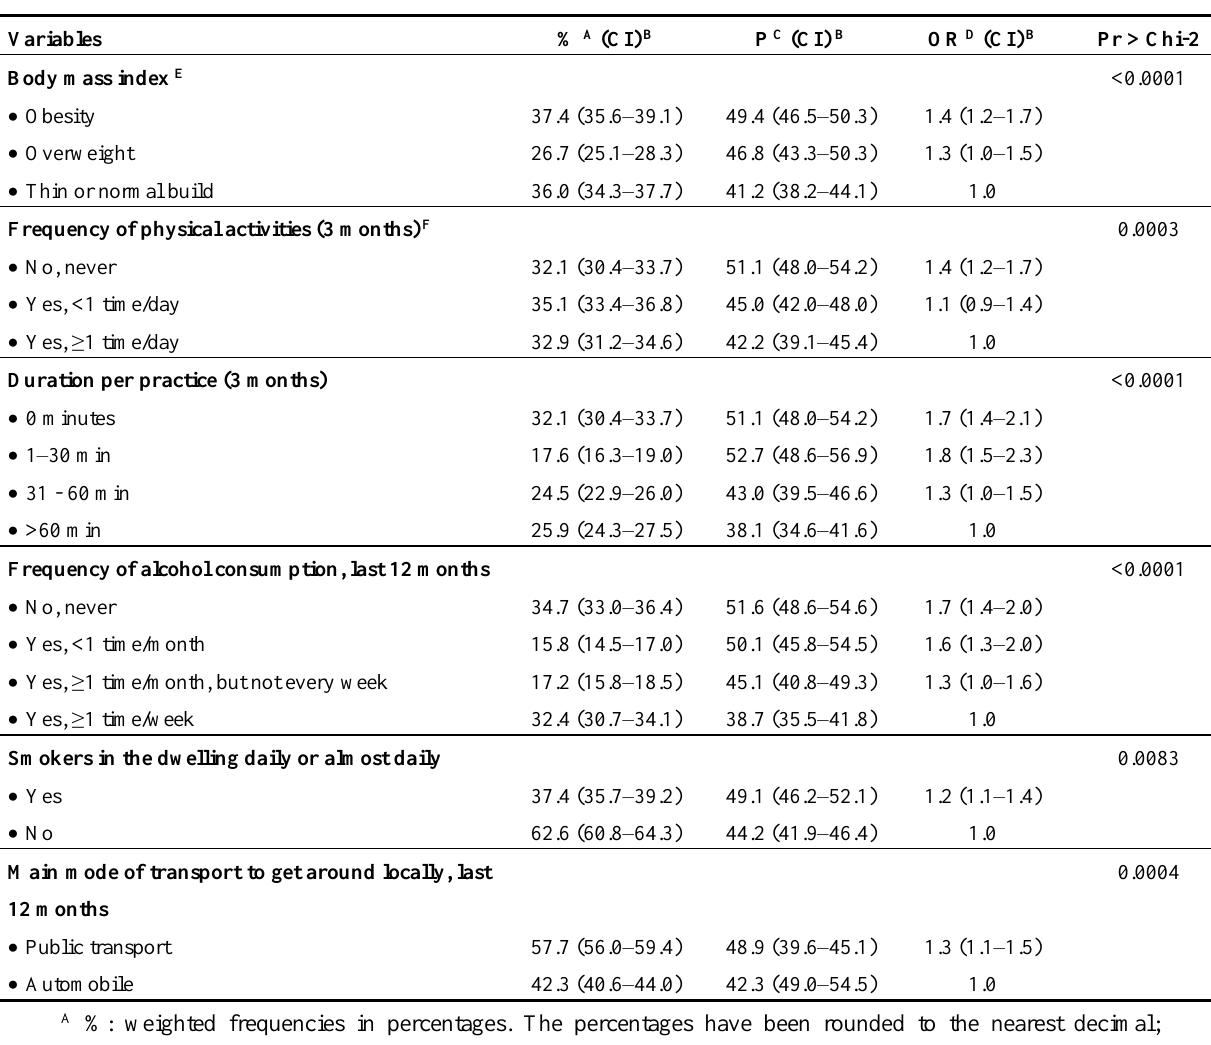
Table 3. Prevalence of reported adverse health impacts, very hot and humid summer conditions, based on